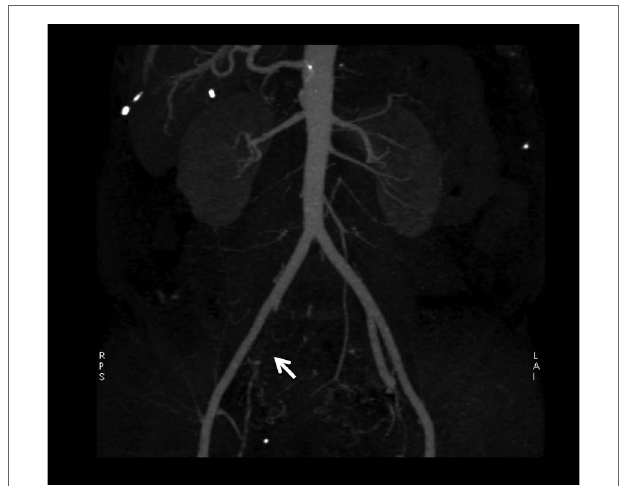
FiGURe 2 | Results of computerized-tomodensitometric angiography: occlusion of the right internal iliac artery . Arrow, occlusion of the right internal iliac